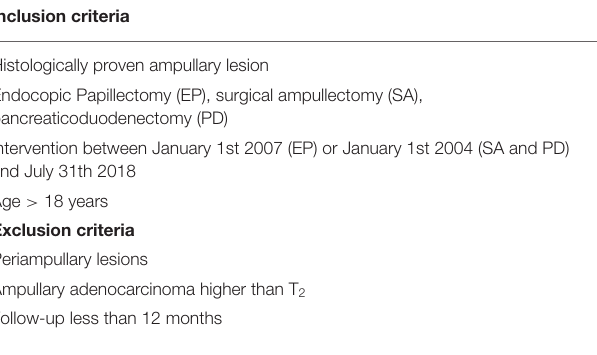
TABLE 1 | Inclusion and exclusion